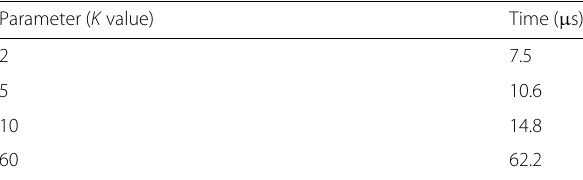
Table 3 Processing time of the proposed algorithm under Intel Core i7-7700K CPU (4.2